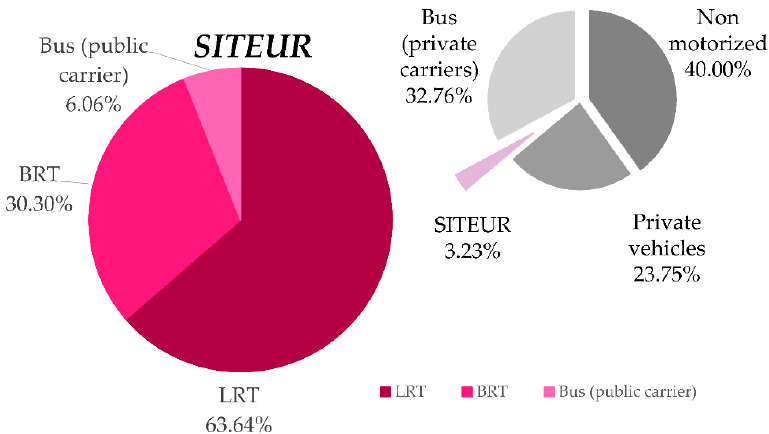
Figure 2. Modal Split in the Guadalajara Metropolitan Area (Percentage of Work-Day Journeys).